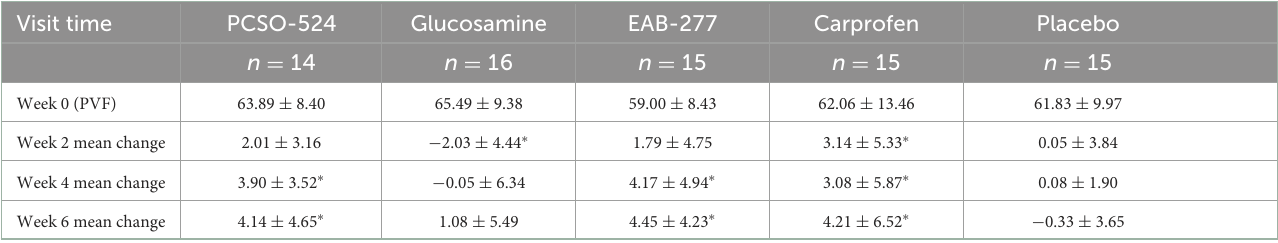
TABLE 6 The mean ( ± standard deviation) change in PVF in the treatment groups at 2, 4, and 6 weeks following initiation of